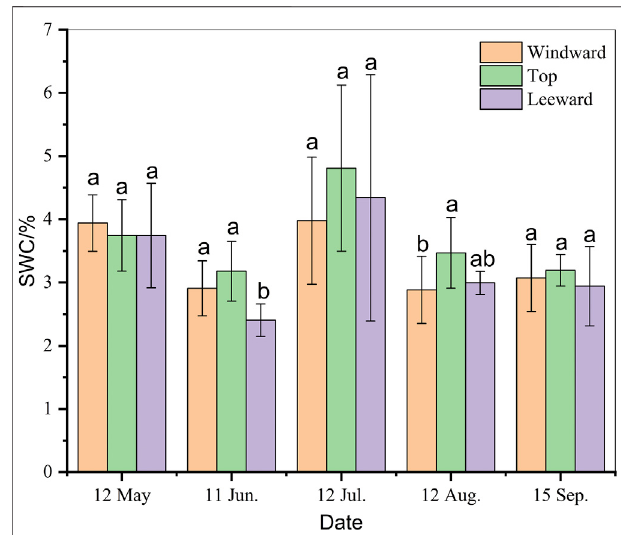
FIGURE 2 | Seasonal variation in soil water content (SWC, %) beneath Artemisia ordosica (Ao) in positions with different dune geomorphology. The same letter means that there is no signi fi cant difference between different positions of dune ( p > 0.05), whereas different letters refer to signi fi cant differences between micro-landforms in dune ( p <